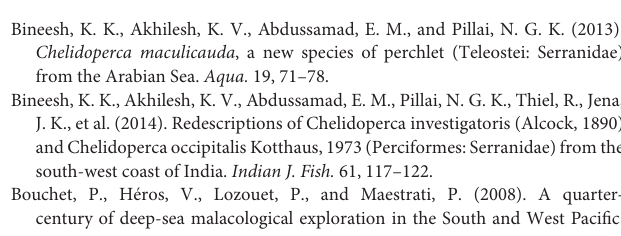
Supplementary Figure 3 | Teeth on both jaws in Chelidoperca barazeri sp. nov. (A) ; C. leucostigmata sp. nov. (B) ; C. microdon sp. nov. (C) ; and C. tosaensis (D) . (A) NTUM15639 (PNG1830, holotype), collected on 25 Apr 2014; standard length 33.0mm (photographed by MYL); (B) NTUM14721 (WJC5843, holotype), collected on 26 Jul 2015; standard length 85.0mm (photographed by MM); (C) MNHN 2019-0020 (NC577, holotype), collected on 20 Aug 2016; standard length 79.5mm (photographed by MM); (D) NTUM12346 (PNG3471), collected on 6 Sep 2014; standard length 73.2mm SL (photographed by MM). Supplementary Figure 4 | Pigmentation on the tips of the lower jaw of C. microdon sp. nov. (A) and C. tosaensis (B) . (A) MNHN 2019-0020 (NC577, holotype), collected on 20 Aug 2016; standard length 79.5mm (photographed by MM); (B) NTUM12346 (PNG3471), collected on 6 Sep 2014; standard length 73.2mm SL (photographed by MM). Supplementary Table 1 | Taxa examined in this study, sample localities and depths (if known), corresponding accession numbers to tissues/vouchers (if any), and corresponding GenBank accession numbers for gene sequences (new sequences highlighted in